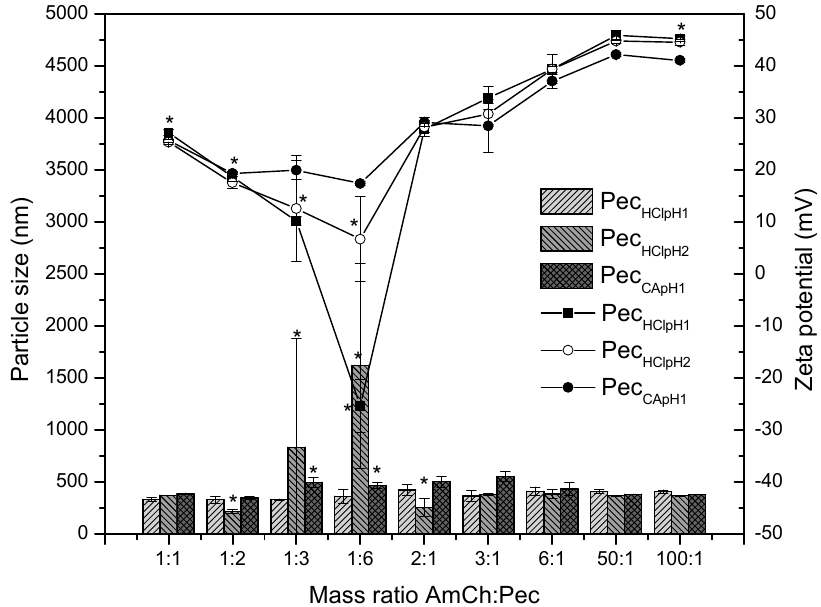
Figure 4. Effect of mass ratio of AmCh:Pec on the particle size and zeta potential using the pectin samples Pec HClpH1 , Pec HClpH2 and Pec CApH1 . Statistically significant: * p = 0.00.